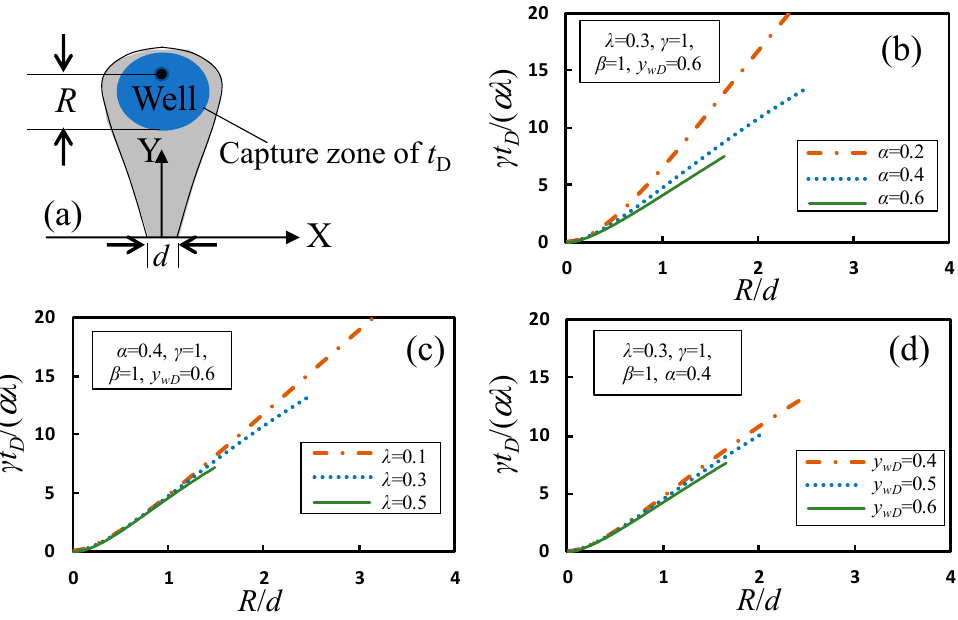
Figure 13. The size factor of a capture zone ( a ) with limited travel time in a type-I catchment for a well on the Y -axis and the curves of γ t D / ( αλ ) versus R / d with varying α ( b ), λ ( c ) and y wD ( d